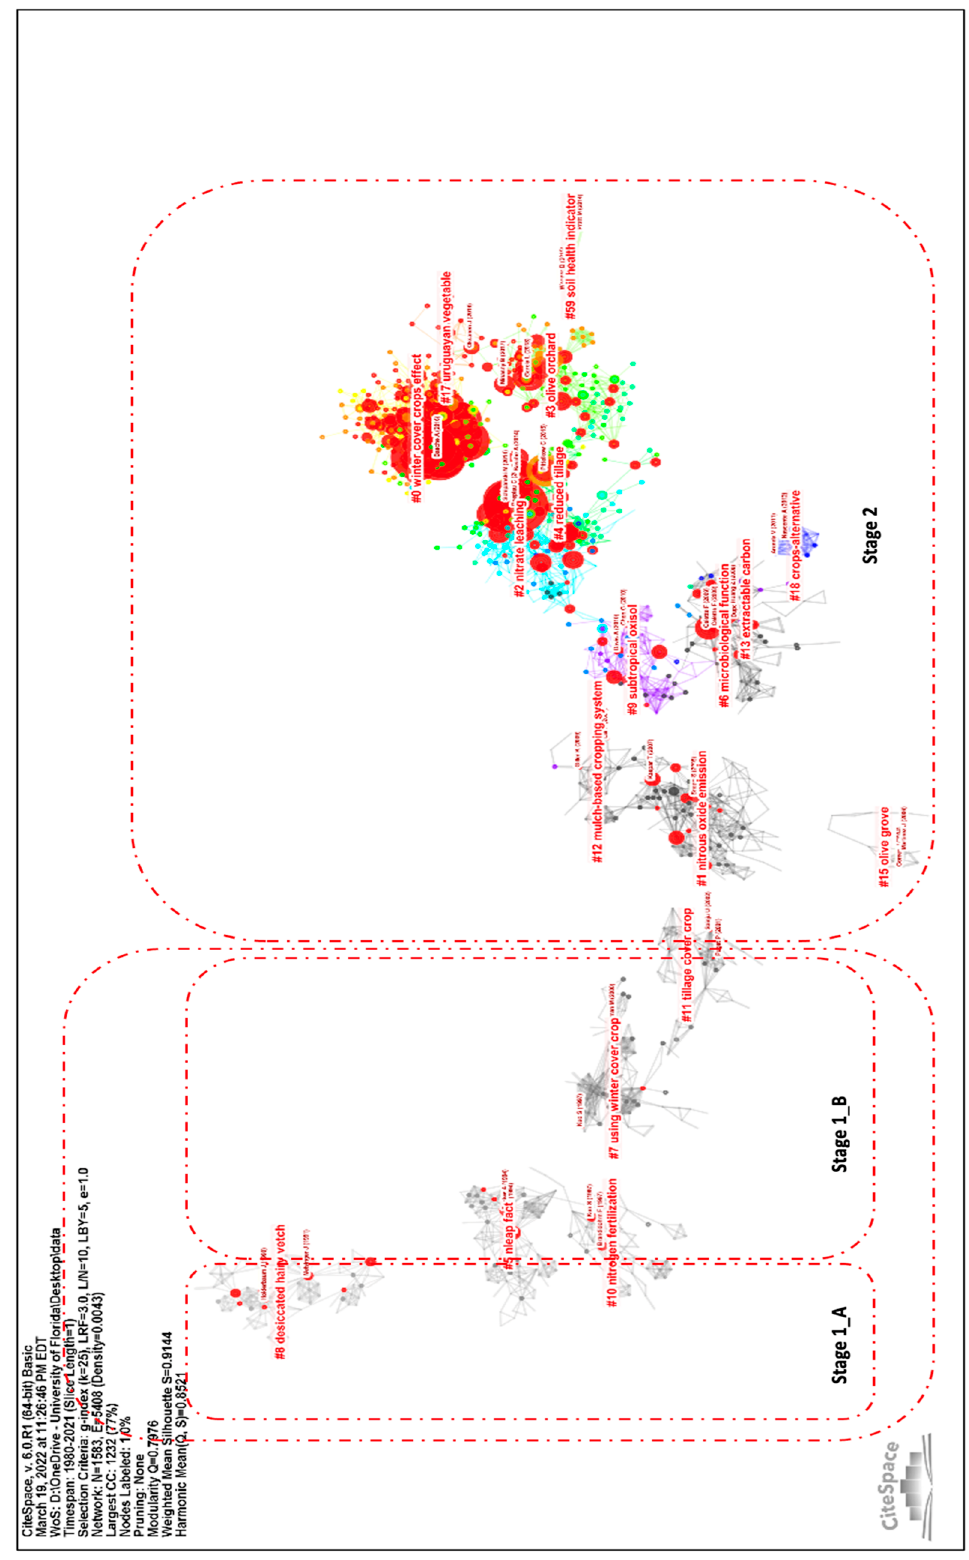
Figure 5. Cluster view of the co ‐ citation network. Table 5. Top 5 terms in citation ‐ clustering results.